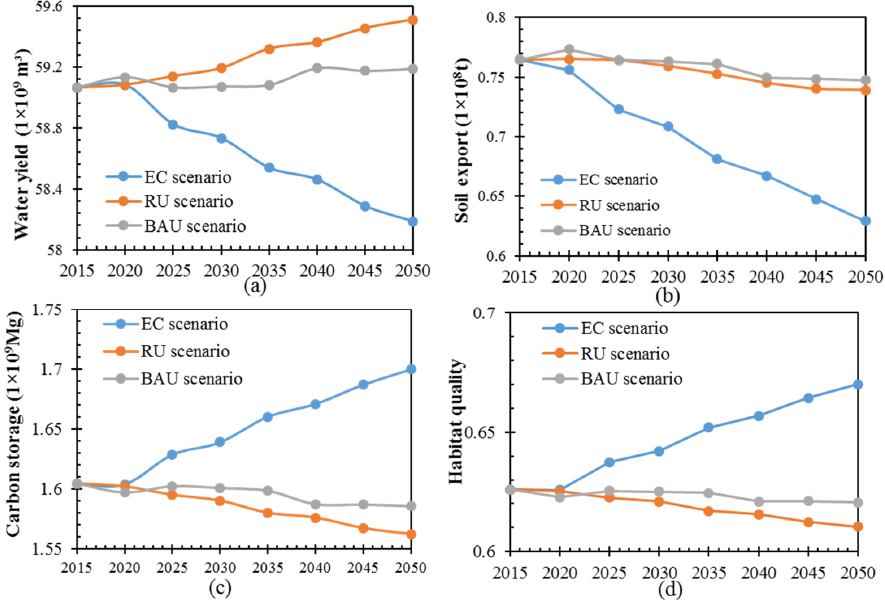
Figure 6. Trends of ecosystem services from 2020 to 2050 (at five-year intervals) under the three scenarios. EC represents ecological conservation. RU represents rapid urbanization. BAU represents business as usual. The changes in the provision of water yield ( a ), soil export ( b ), carbon storage ( c ), and habitat quality ( d ) under the three scenarios from 2020 to 2050.